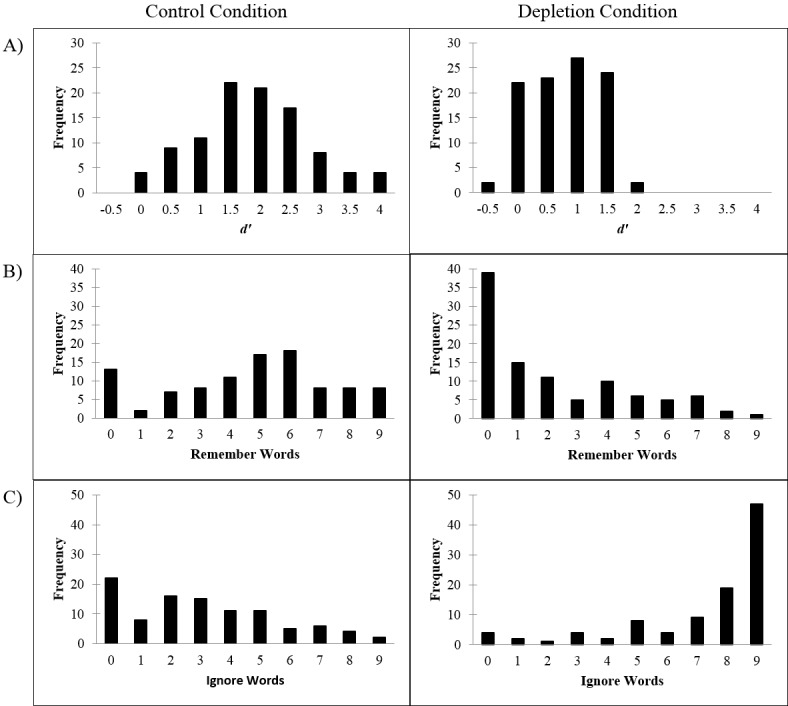
Histograms depicting strategies used during the video task.Higher numbers on the x-axes reflect better memory performance (A), greater effort to remember the words (B), and greater effort to ignore the words (C).